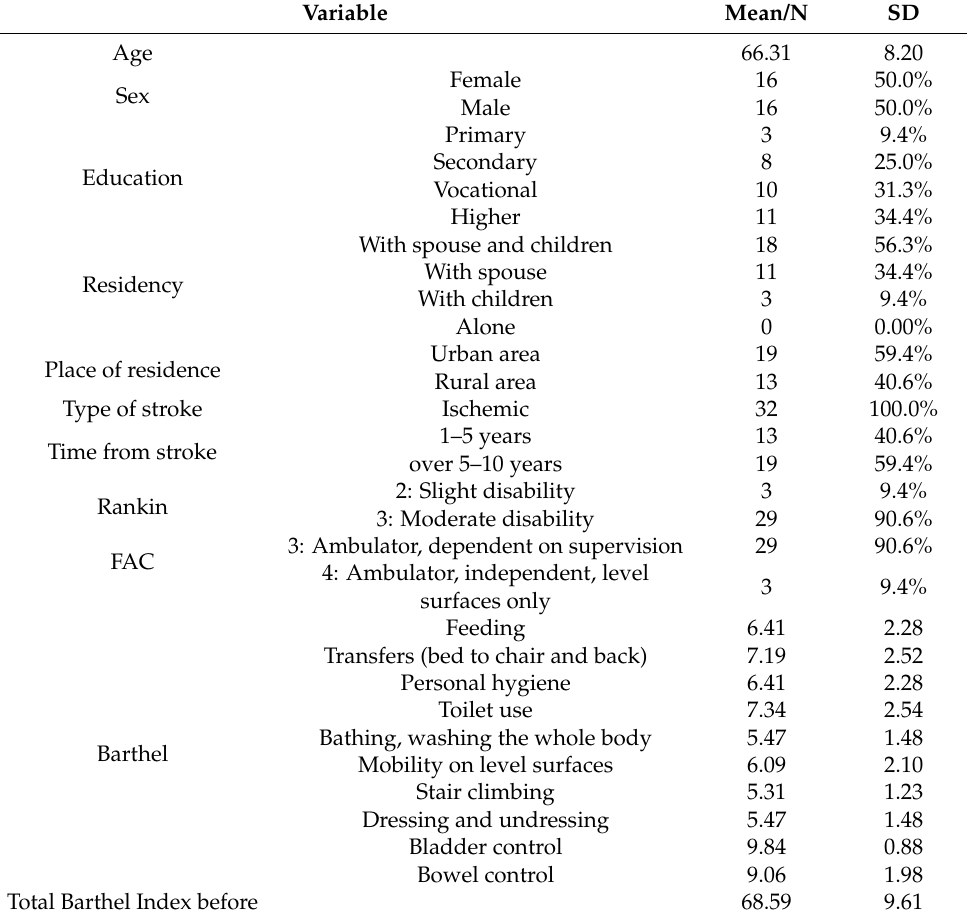
Table 1. Characteristics of each patient’s baseline